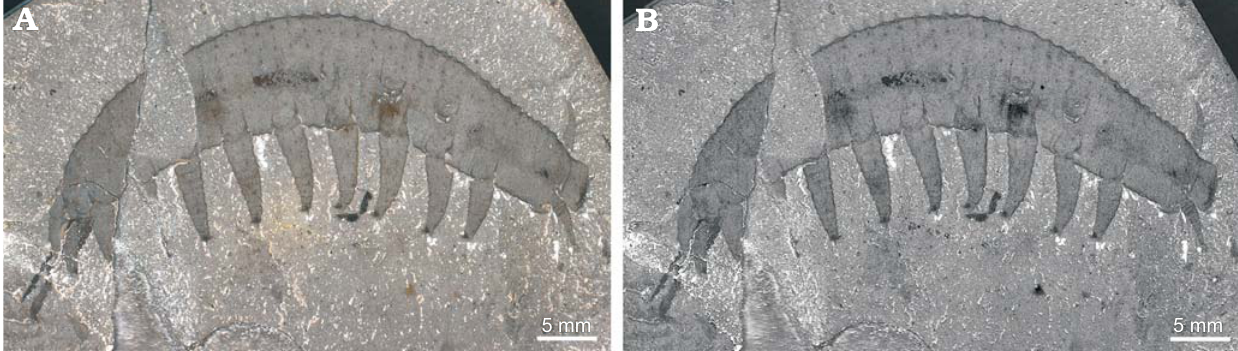
Fig. 4. Lobopodian Aysheaia pedunculata Walcott, 1911, USNM 365608 from the Stephen Formation (Cambrian Series 3, Stage 5), British Columbia, Canada; in cross-polarized light ( A ), cross-polarized light, red and yellow channels reduced ( B ).